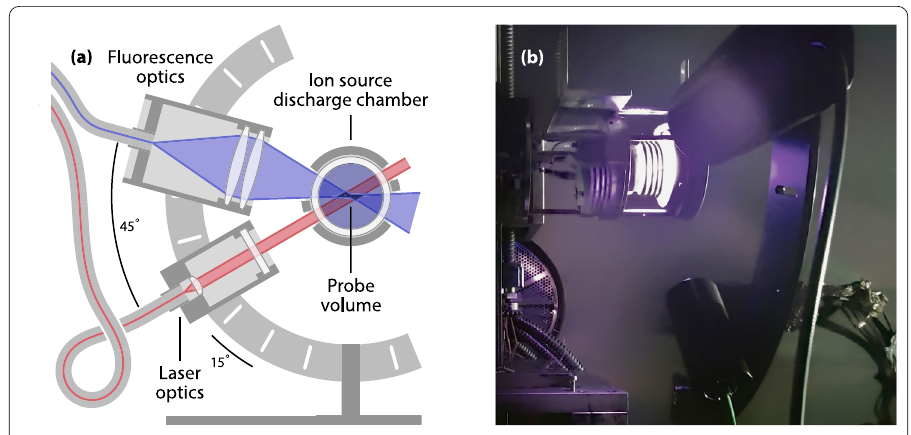
Figure 5 ( a ) Schematics of the LIF vacuum optics arrangement (not to scale). The effective viewing angles of the optical probes are restricted due to supporting elements of the ion source; the intermediate angle between laser propagation and detection axis was set to 45 degrees for optimum laser insertion and fluorescence detection. ( b ) Ion source discharge chamber and the LIF vacuum setup in side